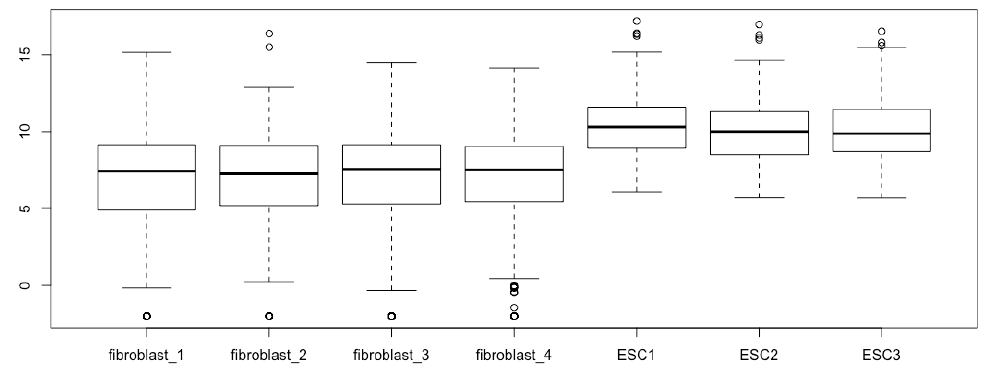
Figure 4. Visualize the -Inf outliers (open circles; compare with Figure 3).